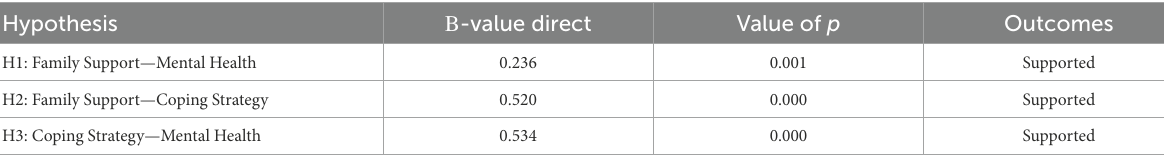
TABLE 6 Hypothesis testing for direct relationship.